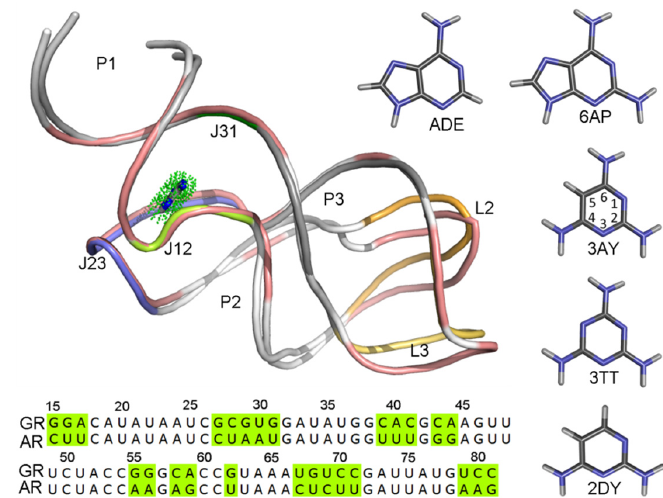
Figure 1. The superimposition of structures and comparison of sequences for the guanine (GR) and adenine riboswitches (AR). The structures of riboswitches are shown in cartoon representation. The structures with different sequences of two purine riboswitches are colored in salmon color for GR, AR is colored with each secondary structure and labeled. The ligand in the binding pocket is shown using a stick-and-dot representation. Five ligands are also shown in stick representation.